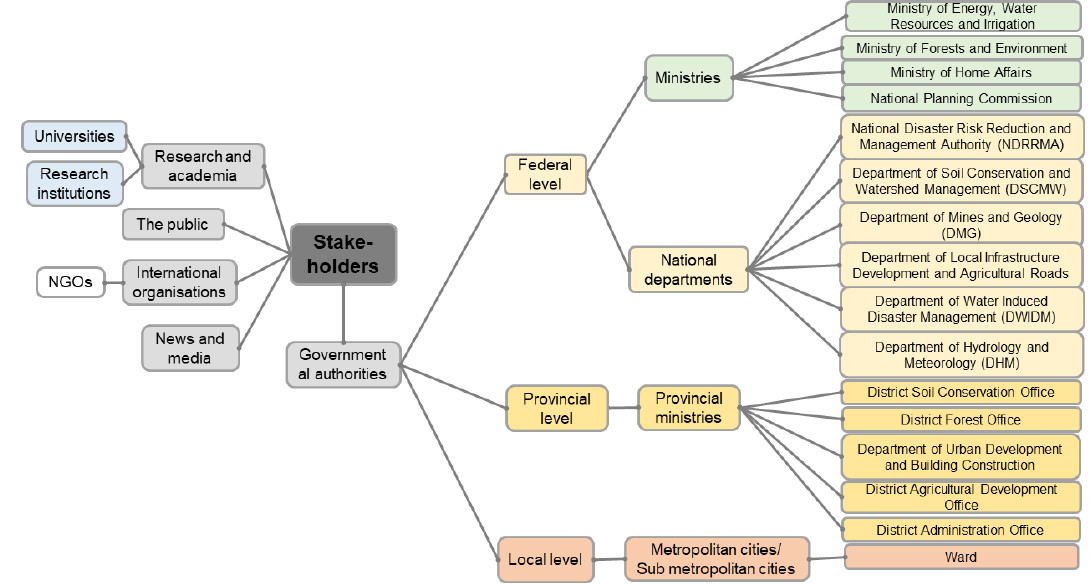
Figure 2. Stakeholder’s overview and organisational structure in Nepal (Secretariat and Durbar,